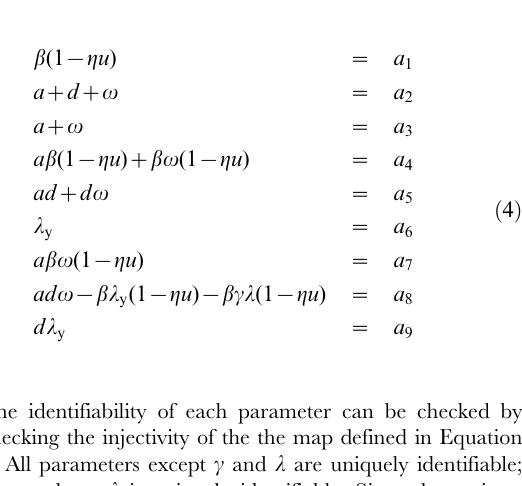
Figure 4. Typical scatter plot of R 0 correlation. The heavy correlation between the elements in the numerator and denominator of R 0 demonstrates the strong higher-order correlation between param-